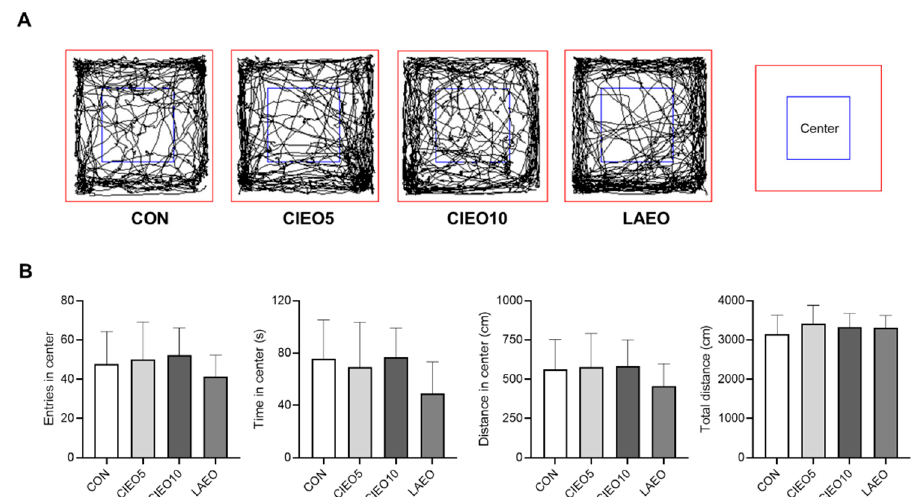
Figure 2. Effect of CIEO on locomotor activity in mice. ( A ) Traveling paths in the OFT. ( B ) The entry number, time, distance in the center, and total distance were recorded in a 10-min session. Data represent means ± SDs ( n = 8 per group). CON: control; CIEO: cinnamon essential oil; LAEO: lavender essential oil; OFT: open field test.